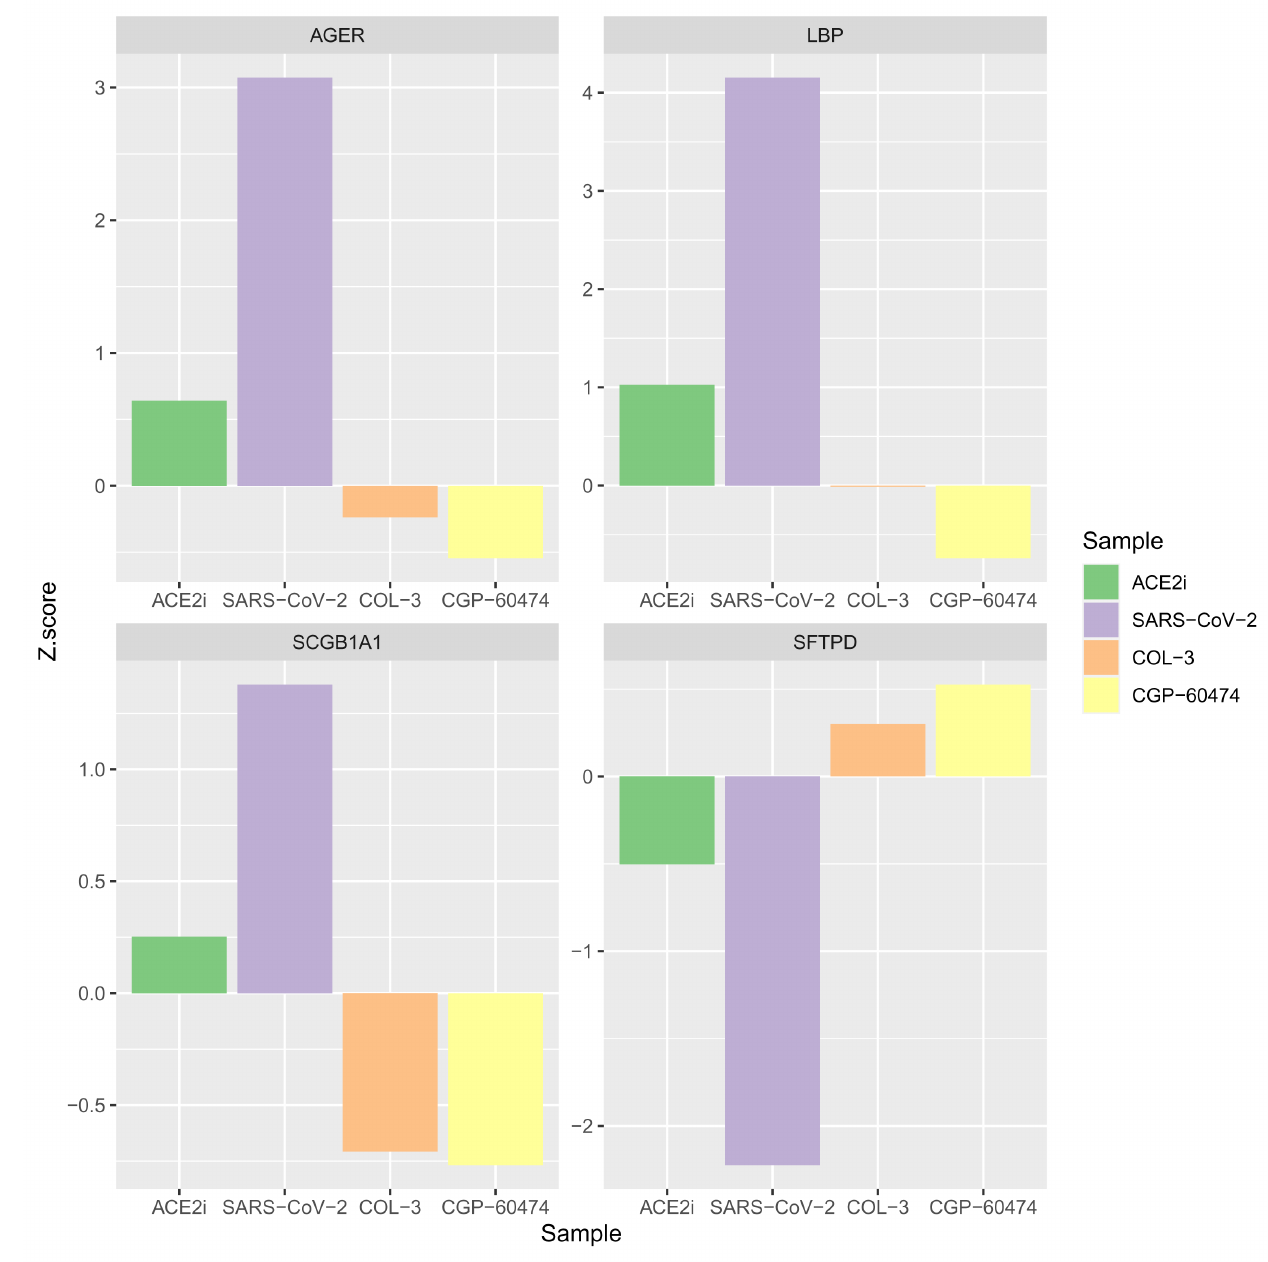
Figure 2. COL-3 and CGP-60474 can reverse the expression of marker genes of lung injury. Z-score: z score of differential expression of genes in the sample; ACE2i: HCC515 cells with ACE2 inhibitor inhibition; SARS-CoV-2: human lung tissues from COVID-19 patients deceased from SARS-CoV-2 induced lung complications; COL-3: HCC515 cells treated with COL-3; CGP-60474: HCC515 cells treated with